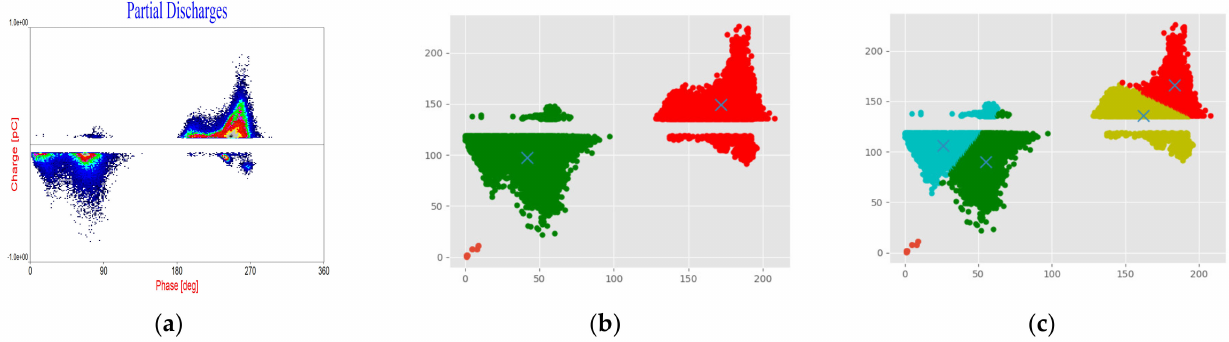
Figure 4. K-means-based clustering of PD image with two discharge groups per phase: ( a ) original image; ( b ) K = 2; ( c ) K = 4.